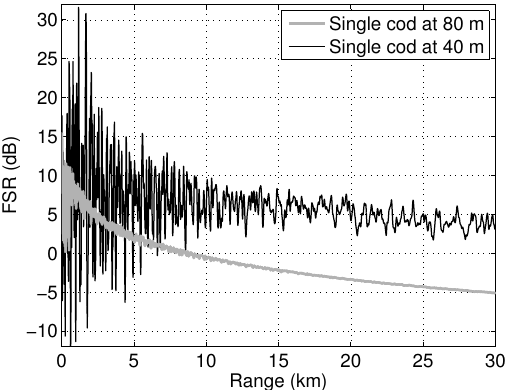
Figure 5. The fish-to-seafloor scattering ratio (FSR) (Equation (5)) as a function of range for OAWRS detection of a single cod at the swim bladder resonance frequency. An individual cod can be detected at least 10 dB above the seafloor scattering when suspended at mid-water column within roughly 8 km of the source, but may not be detected when located on or very close to the seafloor when probed at the swim bladder resonance frequency. The cod is assumed to be neutrally buoyant at its occupancy depth in the water column. The cod is assumed to have a body-length distribution shown in Figure 2A. The seafloor is assumed to have a uniform depth of 80 m. The source and receiver are located at 50 m of depth. Methods for estimation of FSR are described in Section